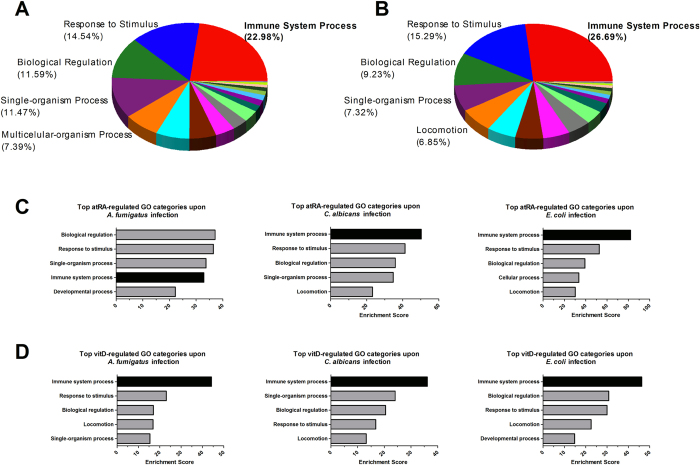
Gene ontology analysis of the vitamin-induced transcriptional changes during infection.Analysis revealed the Immune System Process as the most affected GO category in response to vitamin treatment. (A) GO enrichment analysis of all atRA-regulated genes (1573 genes, FC > 2, p < 0.05) during any of the three analysed infections. Percentage of the total enrichment scores are shown for the top five GO categories (biological process). (B) GO enrichment analysis of all vitD-regulated genes (624 genes, FC > 2, p < 0.05) during any of the three analysed infections. (C) Top atRA-regulated GO categories during each of the infections. (D) Top vitD-regulated GO categories during each of the infections.